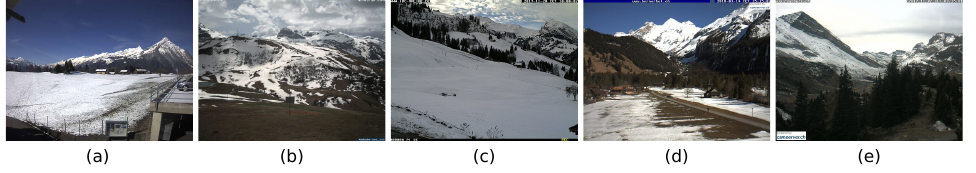
Figure 1. Example images of selected webcams ( a ) Aeschiried (© www.restaurantpanorama.ch (accessed on 24 March 2021)), ( b ) Lenk Hahnenmoos (© Lenk-bergbahnen.ch (accessed on 24 March 2021)), ( c ) Springenboden (© www.springenboden.ch (accessed on 24 March 2021)), ( d ) Kandersteg Bernerhof (© www.bernerhof.ch (accessed on 24 March 2021)), and ( e ) Kandersteg Sunnbüehl (© www. sunnbuel.ch (accessed on 24 March